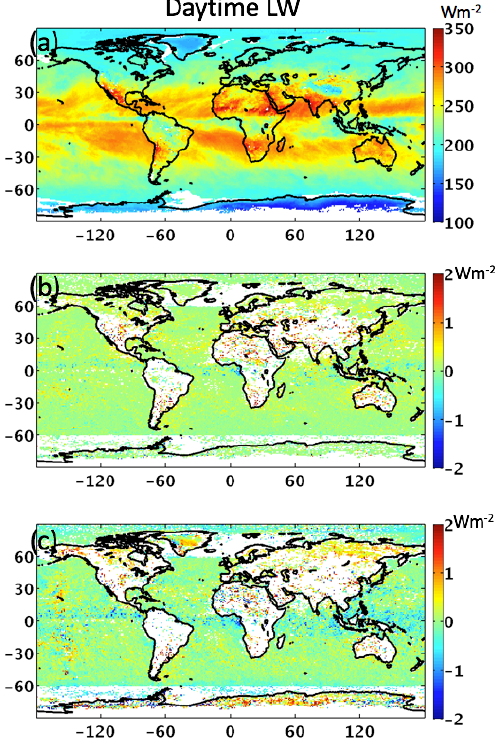
Figure 8. The gridded monthly mean TOA daytime LW fluxes from the simulated Aqua footprints ( F s a , a ), the flux differences caused by footprint size difference between simulated NPP and simulated Aqua ( F s n − F s a , b ), and the flux differences caused by both footprint size and cloud property differences ( F (cid:48) ns − F s a , c ) using April 2013 data. Regions shown in white have large sample number differences between simulated Aqua and simulated